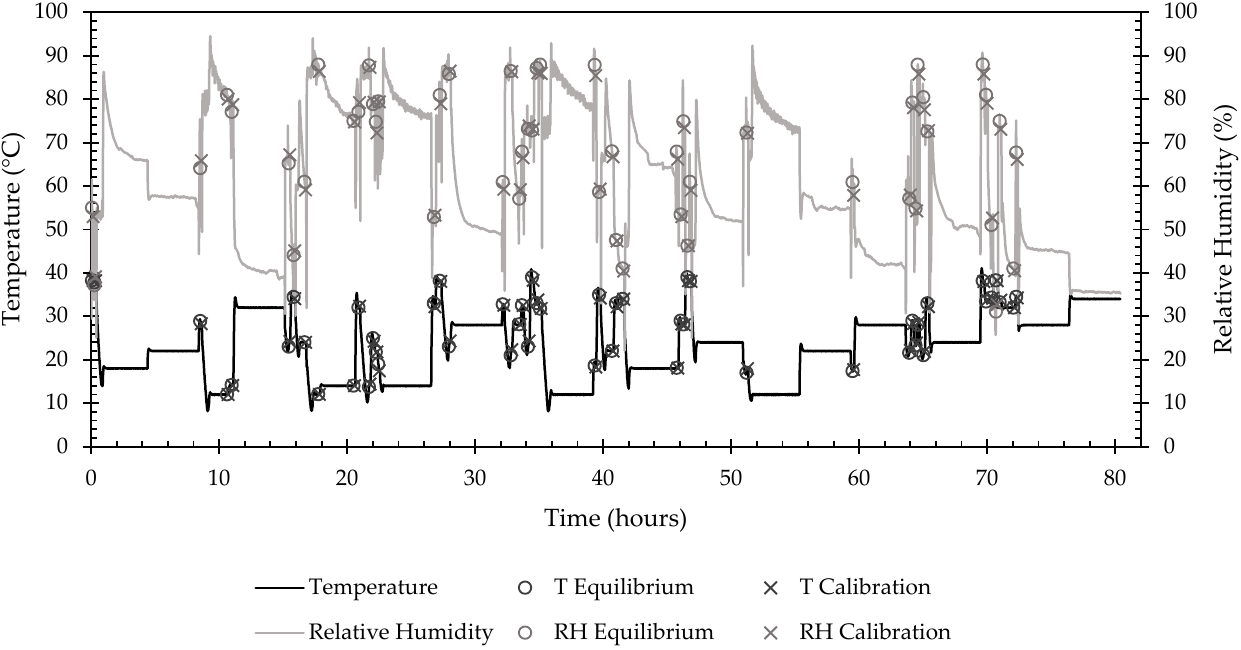
Figure 13. Time response of environmental chamber settings for temperature and relative humidity during validation run, with additional points of interest for the start of equilibrium threshold and calibration data collection periods. Lines show the temperature and relative humidity profiles over the duration of the validation. O’s show that when the chamber reached equilibrium and validation, data collection began. X’s show when validation data collected ended.